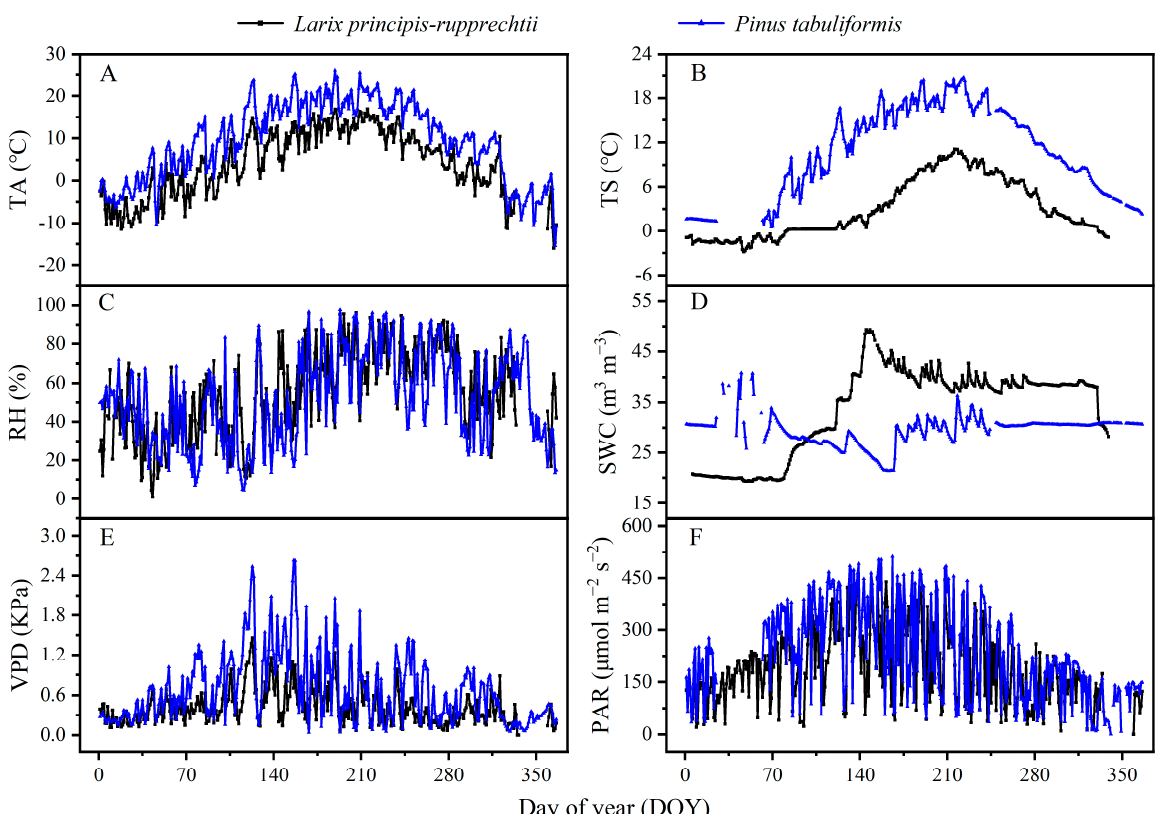
Figure 1. Temporal variations of the daily mean air temperature (TA) ( A ), daily mean soil temperature (TS) ( B ), daily mean air relative humidity (RH) ( C ), daily mean soil water content (SWC) at a depth of 40 cm ( D ), daily mean vapor pressure deficit (VPD) ( E ), and daily mean photosynthetic active radiation (PAR) ( F ) in two forest ecosystems.